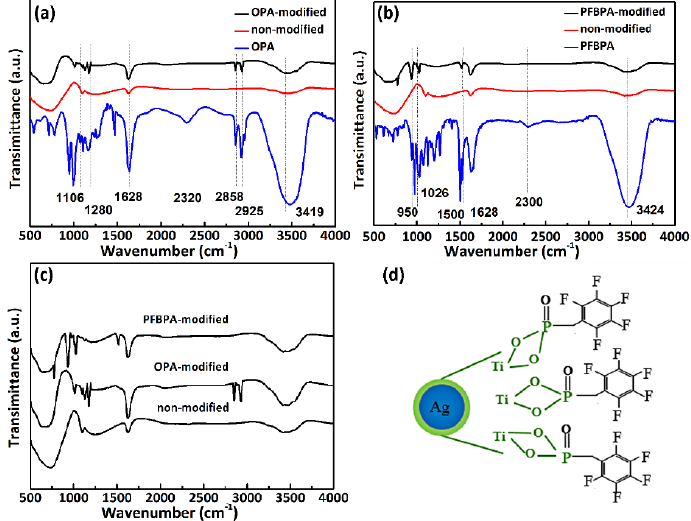
Figure 3. FTIR spectra of Ag/TiO 2 NPs treated with different surfactants: ( a ) OPA; ( b ) PFBPA; ( c ) comparison diagram of OPA-modified, PFBPA-modified, and non-modified; ( d ) proposed surface structure of Ag/TiO 2 NPs modified with PFBPA.